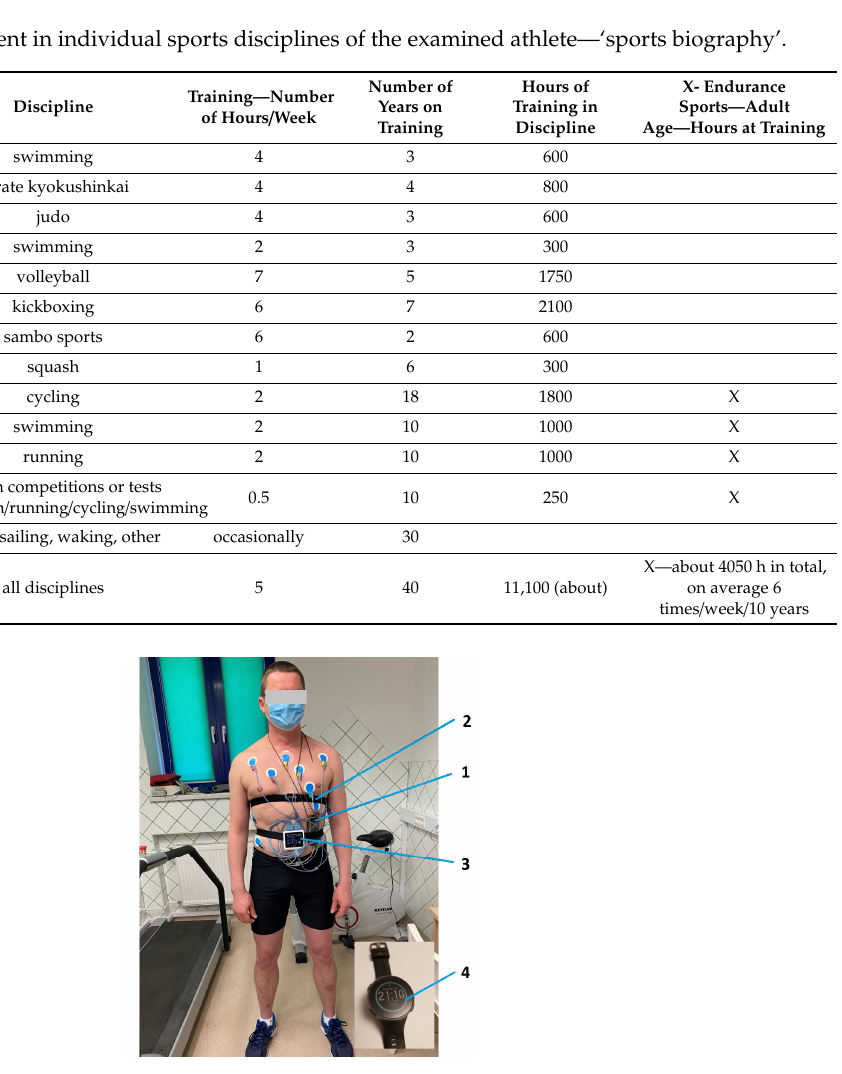
Figure 1. Prepared athlete before exercise stress test on treadmill along with Holter electrocardiogram (ECG) and heart-rate monitor (HRM). 1. Holter ECG, 2. HRM strap, 3. ECG device—from the treadmill exercise stress test set, 4. HRM Polar Vantage V.